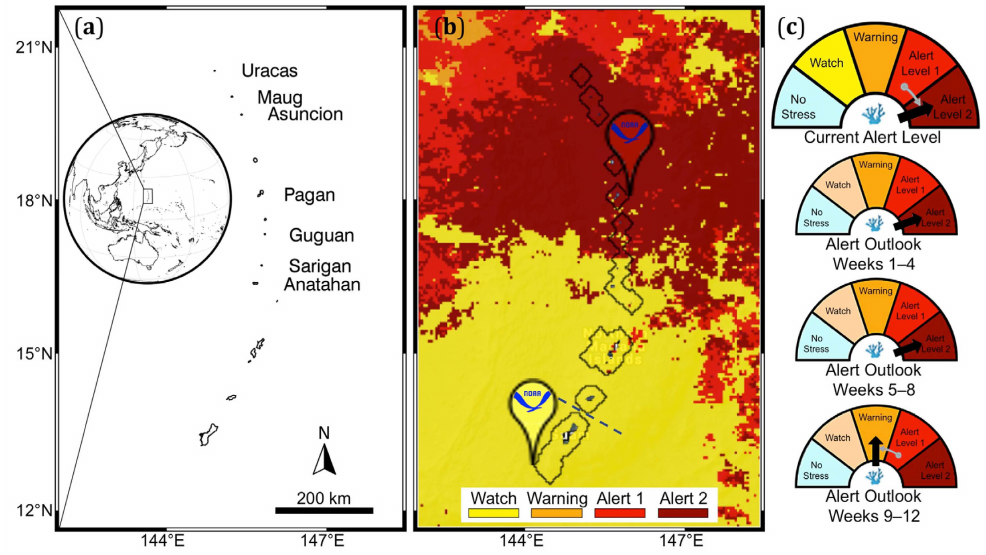
Figure 1. ( a ) Map of the study region identifying islands at which surveys were undertaken; ( b ) Spatial coverage of the Regional Virtual Stations for CNMI (north of dashed line) and Guam include satellite pixels within 20 km of reef-containing pixels (outlined by polygons). The color of customized Google Maps pins (inverted teardrops) indicates the 90th percentile Bleaching Alert Area level for pixels within each Regional Virtual Station. The background image shows the Bleaching Alert Area level on 13 August 2014 displayed in Google Maps [16]); ( c ) Regional Virtual Station gauges for CNMI showing the Bleaching Alert level on 13 August 2014 (top gauge) and the forecast stress levels in the subsequent three months. Grey arrows indicate change from the previous gauge